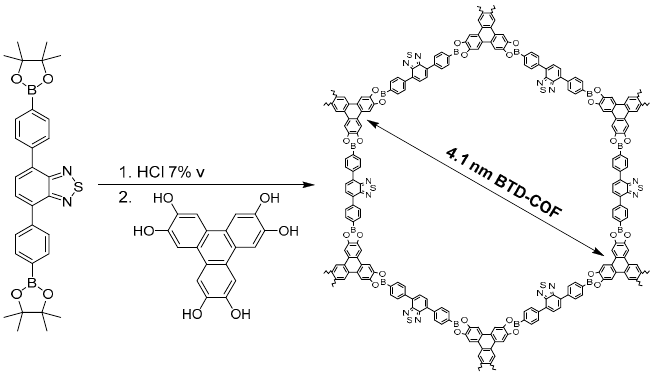
Figure 7. Synthesis of the dioxaborole-linked COF by in-situ deprotection of boronic pinacol ester followed with the addition of HHTP via microwave heating method.